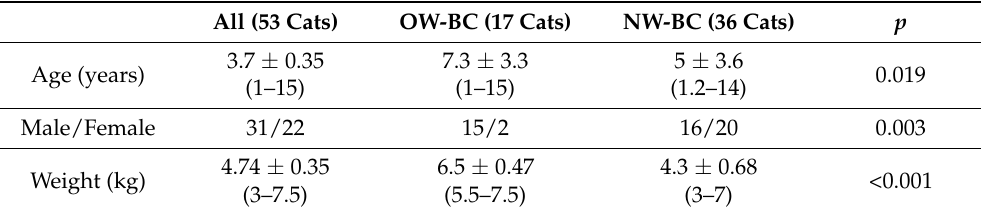
Table 1. Clinical data of the cats evaluated in this study. Data are expressed as mean ± standard deviation with maximum and minimum in brackets. It was observed that OW-BC cats were older and there were more male cats in this group with respect to NW-BC cats. The p value shows the statistical difference among OW-BC cats and NW-BC cats.